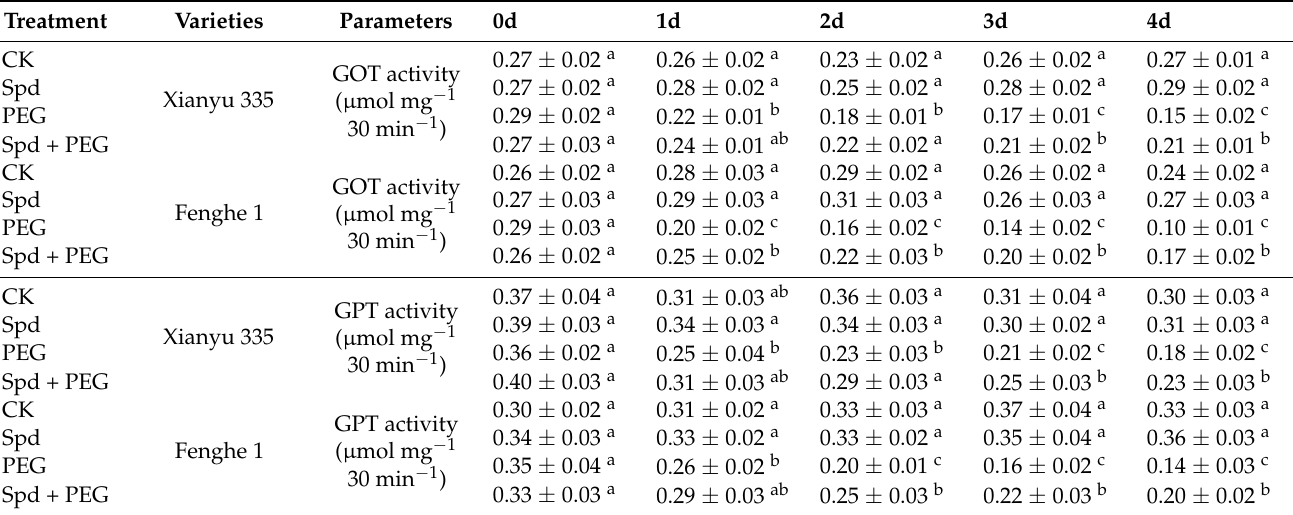
Table 5. Effects of exogenous spermidine on the activities of glutamate-oxaloacetate transaminase (GOT) and glutamate-pyruvate transaminase (GPT) in maize seedlings under drought